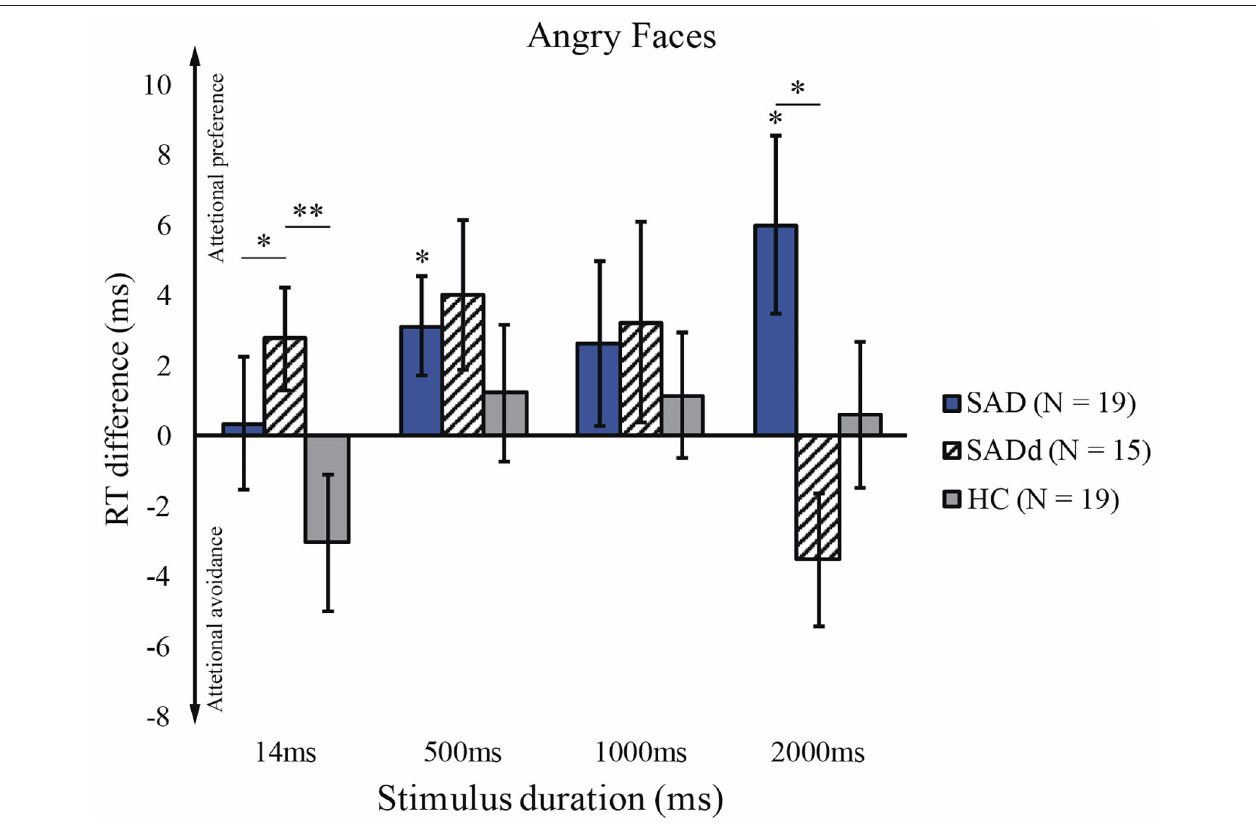
FIGURE 2 | Reaction time difference across groups and stimulus durations for angry faces. The y-axis is the reaction time difference between emotional faces and neutral faces. The error bars represent the S.E.M across participants. Figure conventions are ** p < 0.01, * p < 0.05 (two-tailed). These conventions are kept in all subsequent